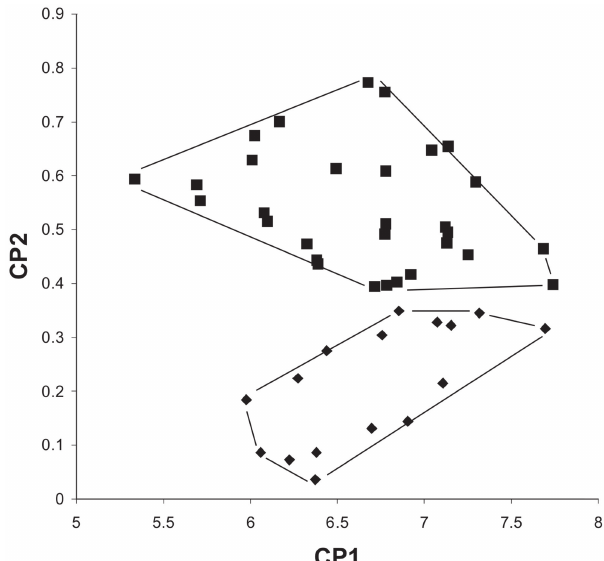
Fig. 9. Scatter plot of combined samples of Rhamdia branneri (n=16, diamonds) and Rhamdia voulezi (n=30, squares) from rio Iguaçu on the first and second principal component axis.